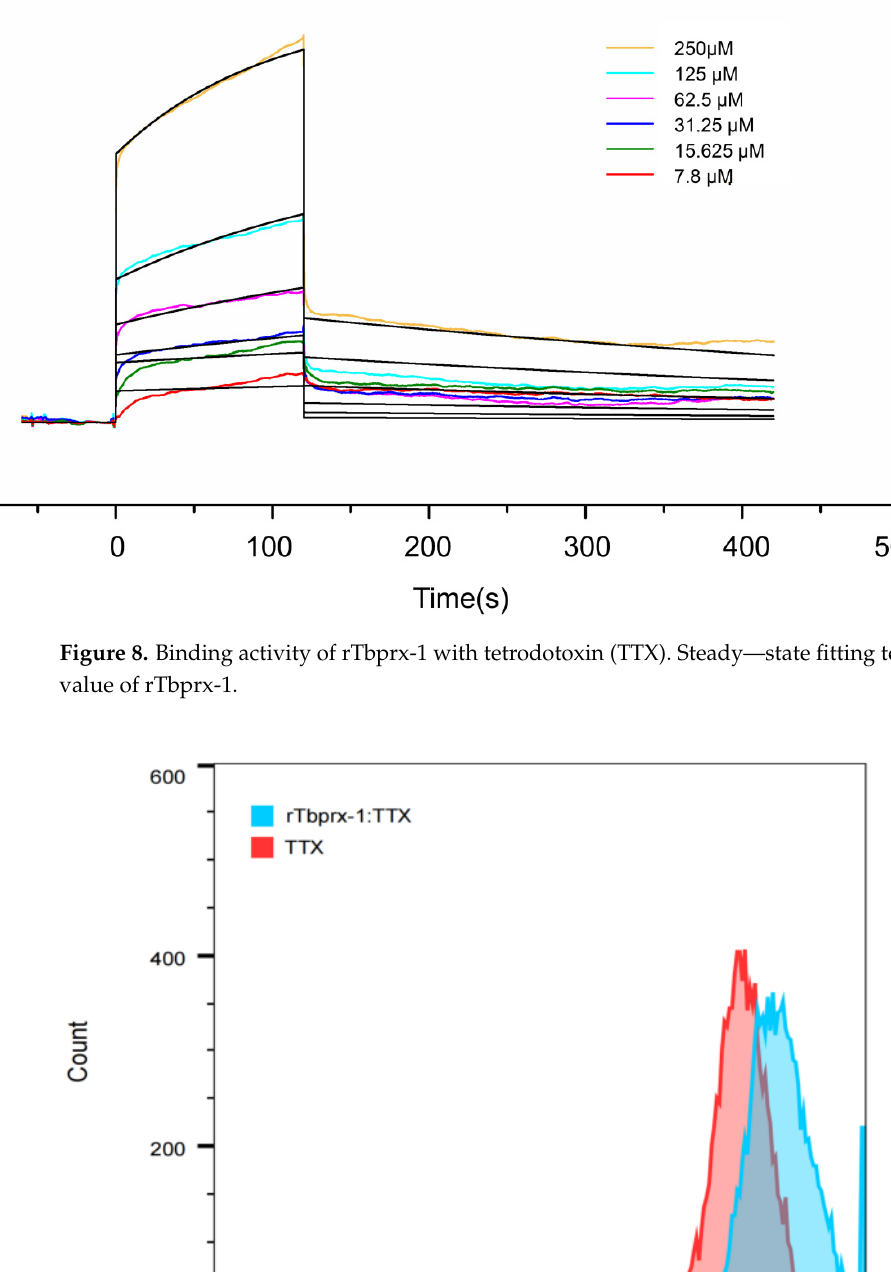
Figure 9. Effects of rTbprx-1 on TTX entry into Epithelioma Papulosum Cyprini (EPC) cells.